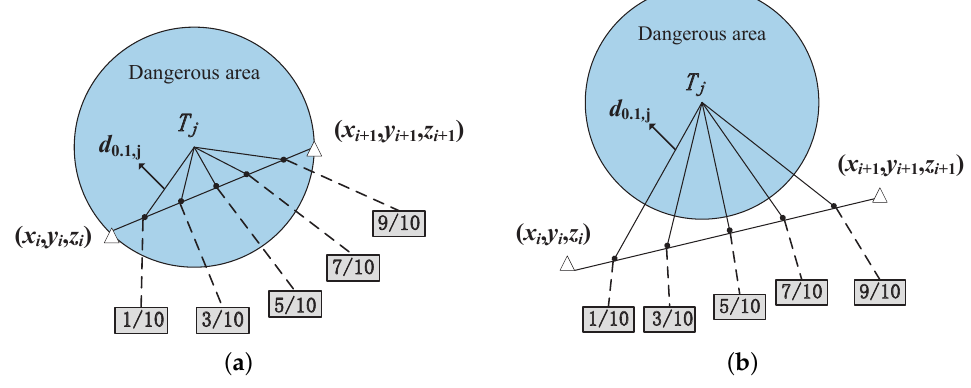
Figure 4. ( a ) Path entering the dangerous area and ( b ) path not entering the dangerous area [29]. The function of the safety fitness to avoid other targets in space is defined as follows: